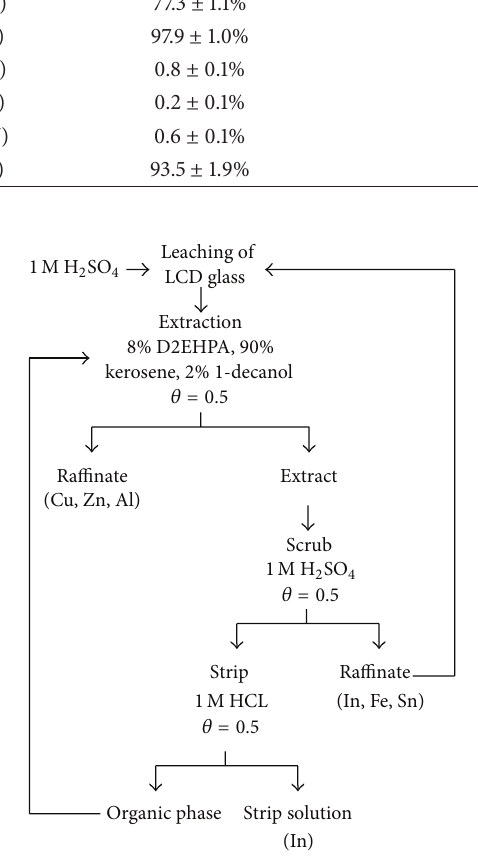
Figure11: Schematic diagram of a potential processfor therecycling of indium from LCD glass, showing an extraction, scrubbing, and stripping step. The aqueous phase was 1M H 2 SO 4 (extraction and scrubbing) and 1M HCl (stripping); organic phase is 0.25 M D2EHPA diluted in kerosene with 2%